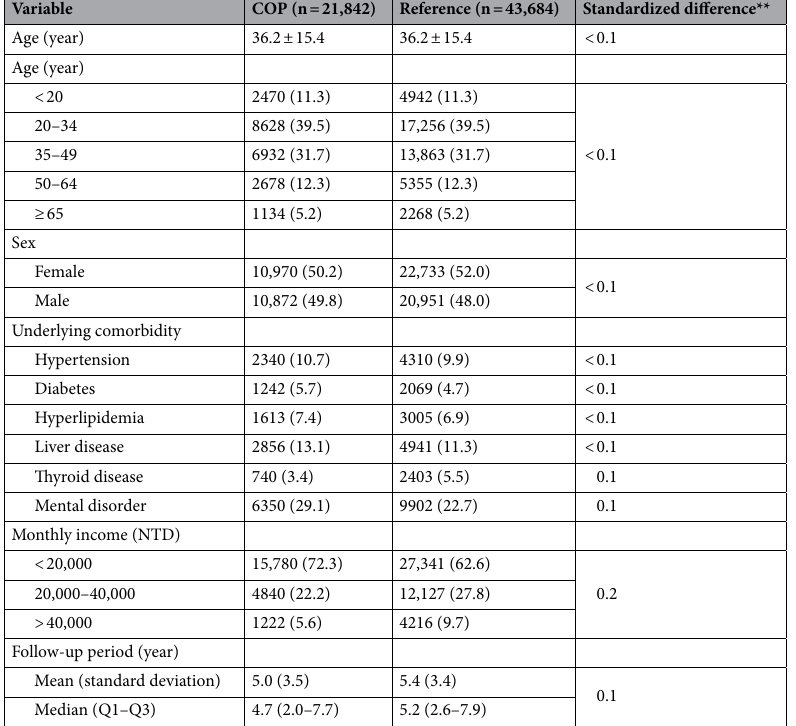
Table 1. Demographic characteristics, underlying comorbidities, and monthly income in COP and reference cohorts. COP carbon monoxide poisoning; NTD New Taiwan Dollars. Data are expressed as mean ± standard deviation or n (%). **Take absolute value.